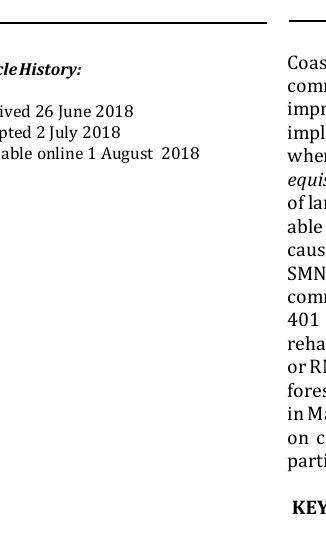
Section A: Demographic profile of the household’s Section B: Perception toward the SMNR conservation Section C: Sources of household’s Figure 1: The structure/organization of questionnaire